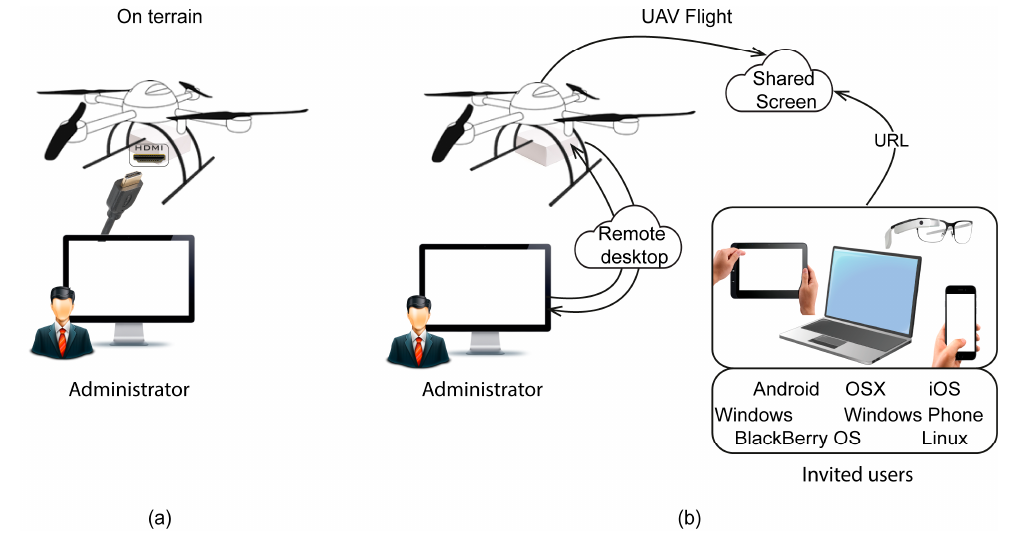
Figure 4. User profiles and cases of use: ( a ) The administrator sets the system on terrain and ( b ) The system onboard an unmanned aerial vehicle (UAV) flight being accessed by the administrator through a remote desktop and invited users with different operating systems accessing inspection via the